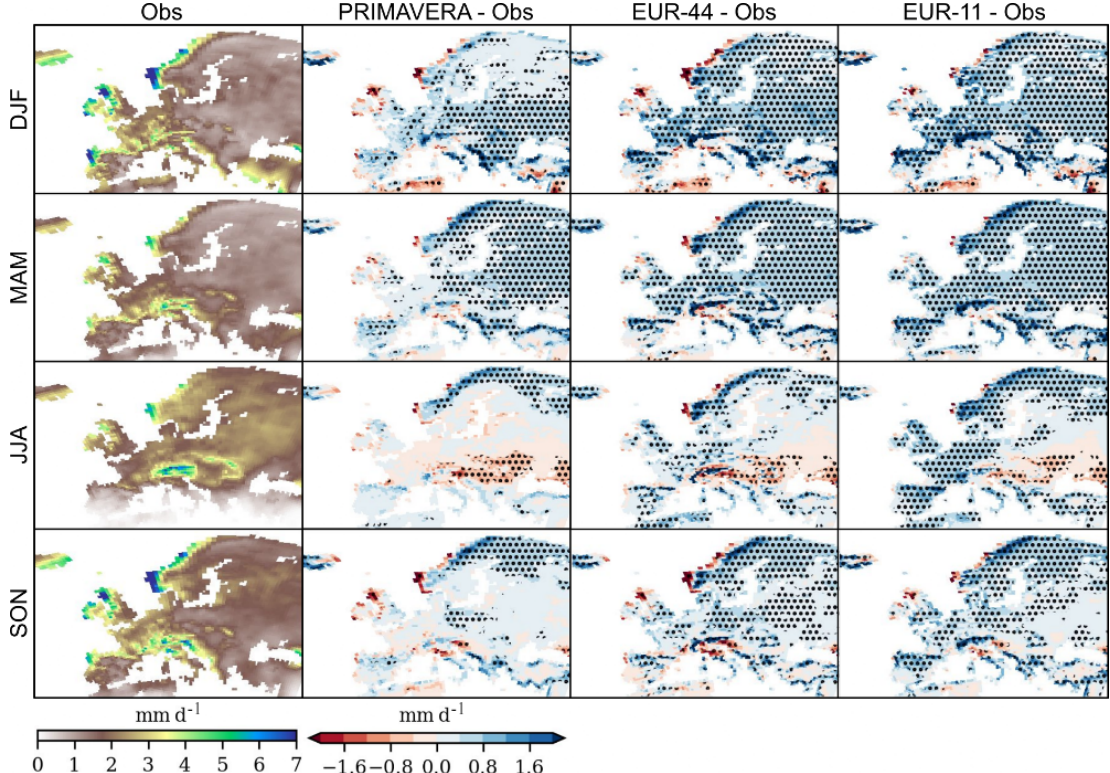
Figure 4. Mean precipitation from the combination of observational datasets (first column) and mean precipitation bias between PRIMAV- ERA and observations (second column), EUR-44 and observations (third column), and EUR-11 and observations (last column). Results for the different seasons are shown in the rows. Dots show regions where mean bias is statistically significant at the 10% level. All datasets are shown on the EUR-44